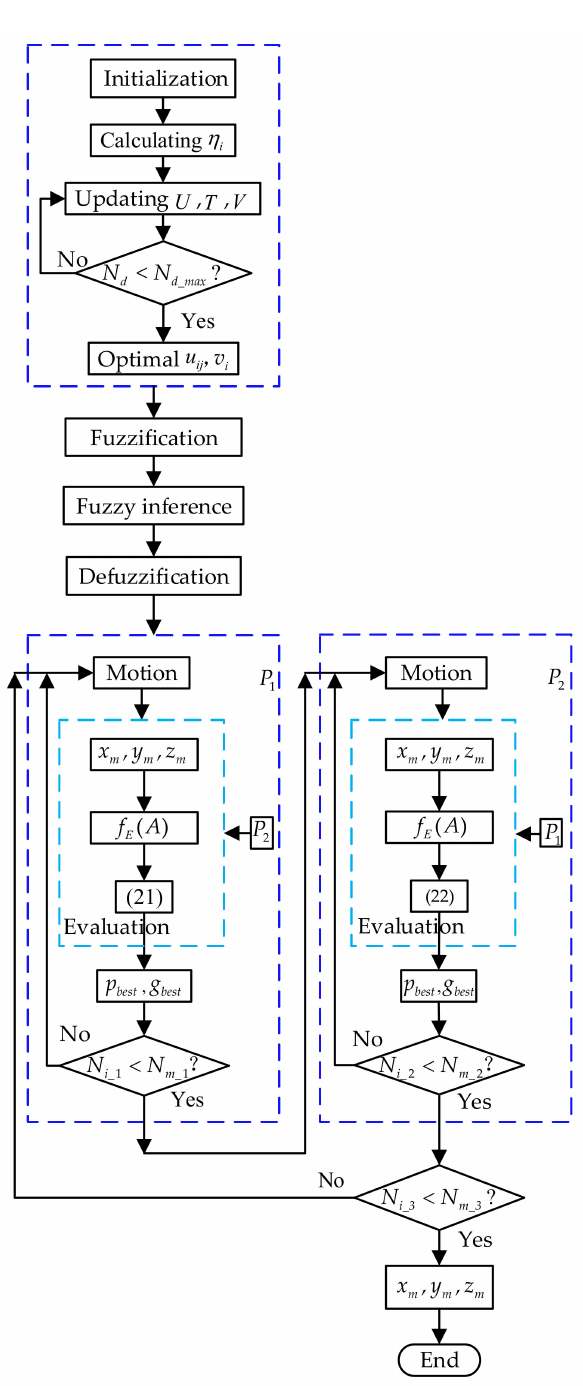
Figure 6. Flowchart for thruster fault diagnostics and fault tolerant control for